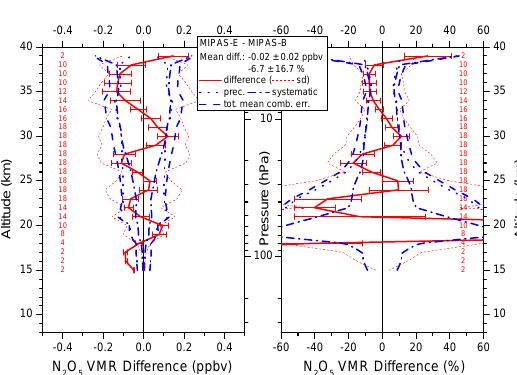
Figure 2: Same as Figure 1, but for the molecule N 2 O 5 . The overall agreement of both sensors is fairly good.